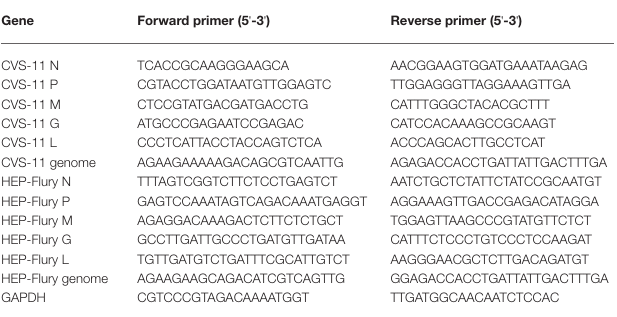
TABLE 1 | Primers used for the analysis of genes expression. Gene Forward primer (5 ' -3 '